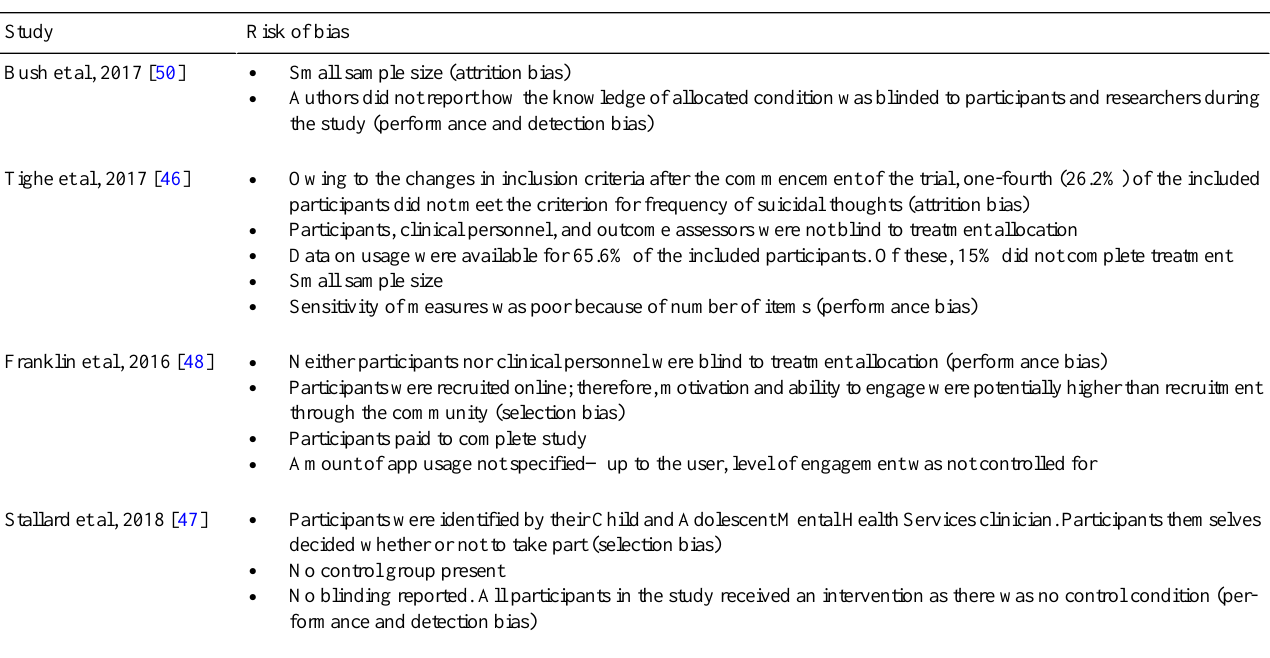
Table 2. Risk of bias in the published studies included. Risk of